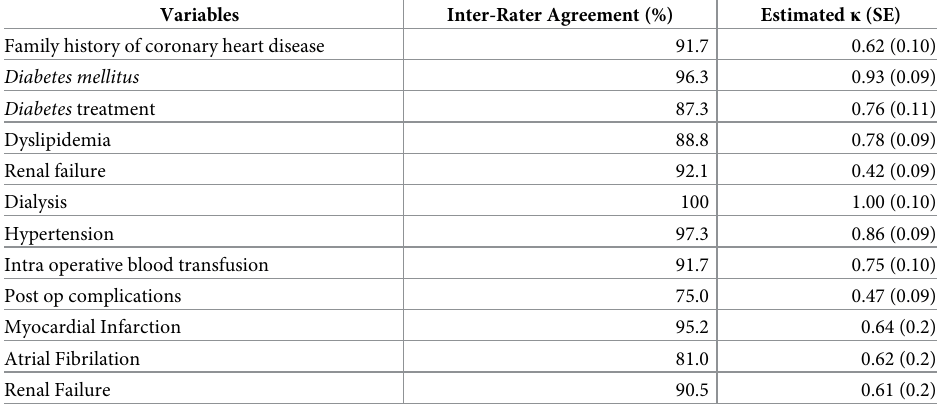
Table 2. Direct audit: Inter-rater agreement and estimated κ coefficient of categorical variables. REPLICCAR II,